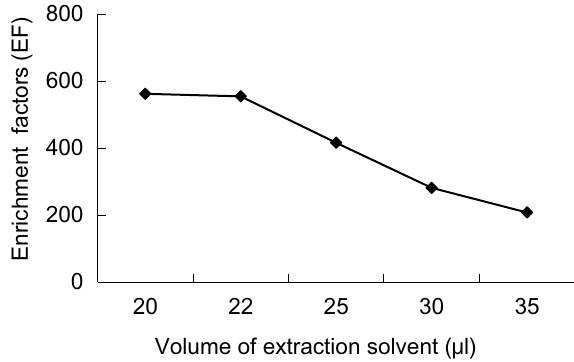
Figure 4. Enrichment factors of different volume of extraction solvent.